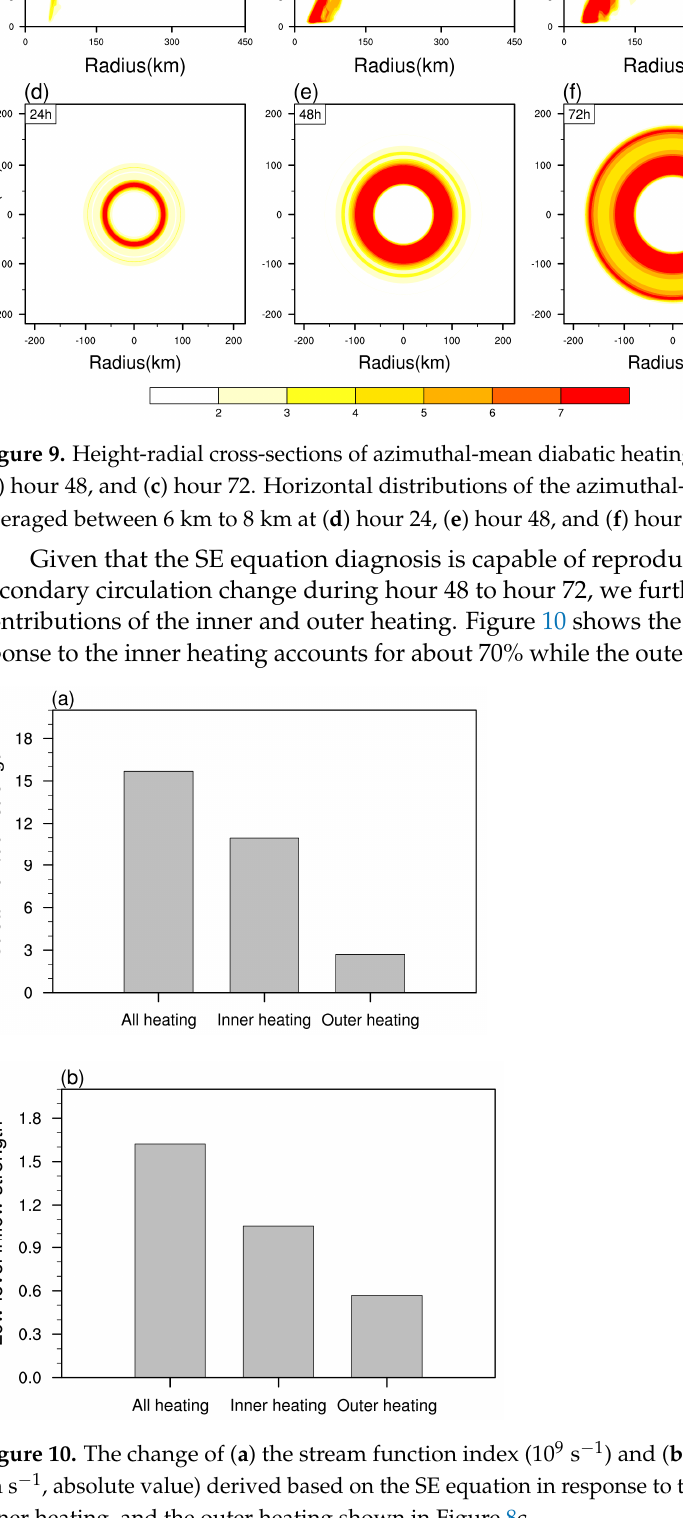
Figure 8. Height-radial cross-sections of the change of azimuthal-mean radial wind (shaded; m s − 1 ) and vertical velocity (contour; m s − 1 ) from hour 24 to hour 48 (i.e., hour 48 minus hour 24) derived from ( a ) the WRF simulation and ( b ) the SE equation diagnoses and ( c ) the change of the diabatic